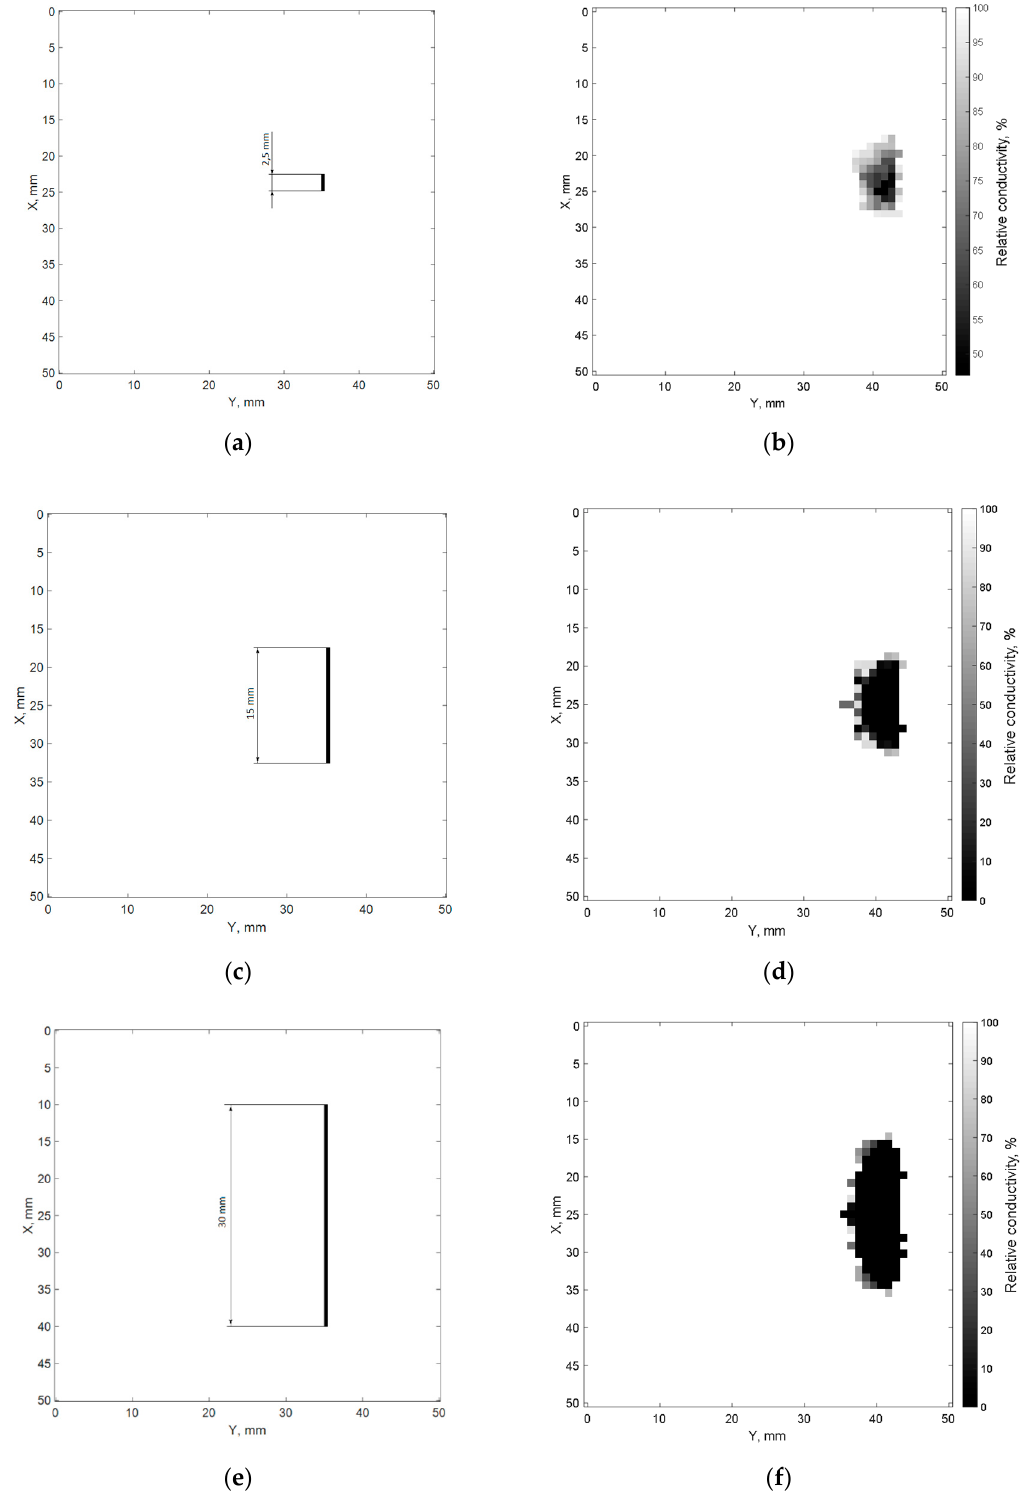
Figure 6. Results of the imitative modeling ( b ), ( d ), ( f ) obtained at a specific conductivity of the initial sensor film of 2.33 × 10 6 S/m, with a grid node number of 49 × 49, at the parameters of the digital filter γ = 1 × 10 4 , K F = 0.05, for the 16 contacts, for crack sizes 2.5 mm ( a ), 15 mm ( c ), and 30 mm ( e ).